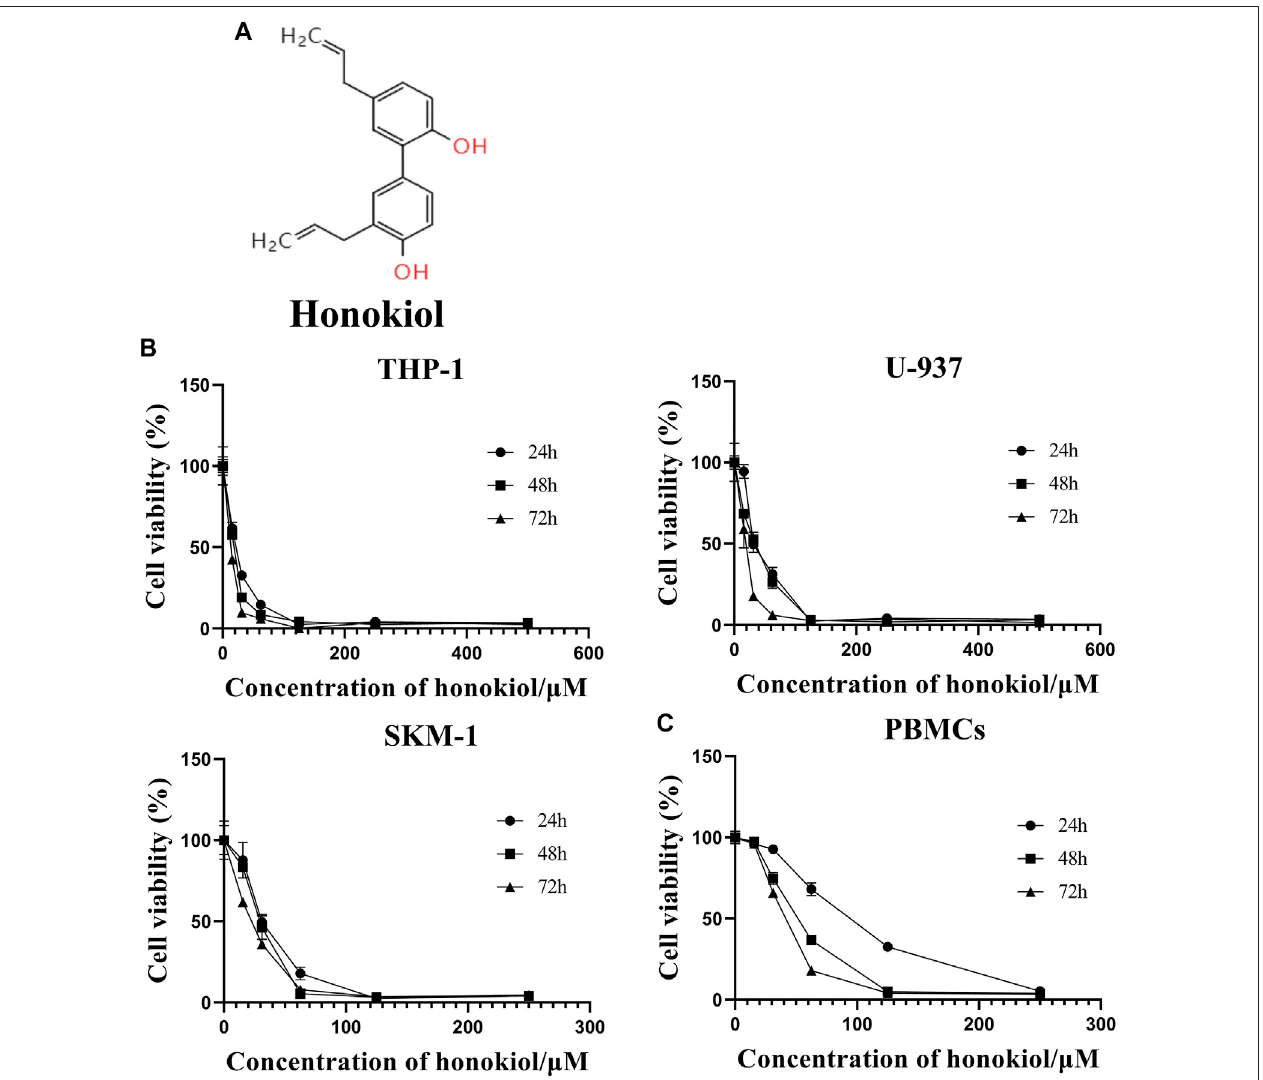
FIGURE 1 | Effects of honokiol on the viability and apoptosis of THP-1, U-937, and SKM-1 cells. (A) Chemical structure of honokiol. (B) Effects of honokiol on the viabilityofTHP-1, U-937, and SKM-1 cells. Cells were incubated with different concentrationsofhonokiolfor24, 48,72 h, then CCK-8 wasadded, and the absorbance at 450 nm was determined. The points represent mean ± SEM from three independent experiments. (C) Cytotoxic effect of honokiol on human PBMCs. PBMCs were incubated with different concentrations of honokiol for 24, 48, 72 h, then CCK-8 reagent was added, and the absorbance at 450 nm was determined. The points represent mean ± SEM from three independent